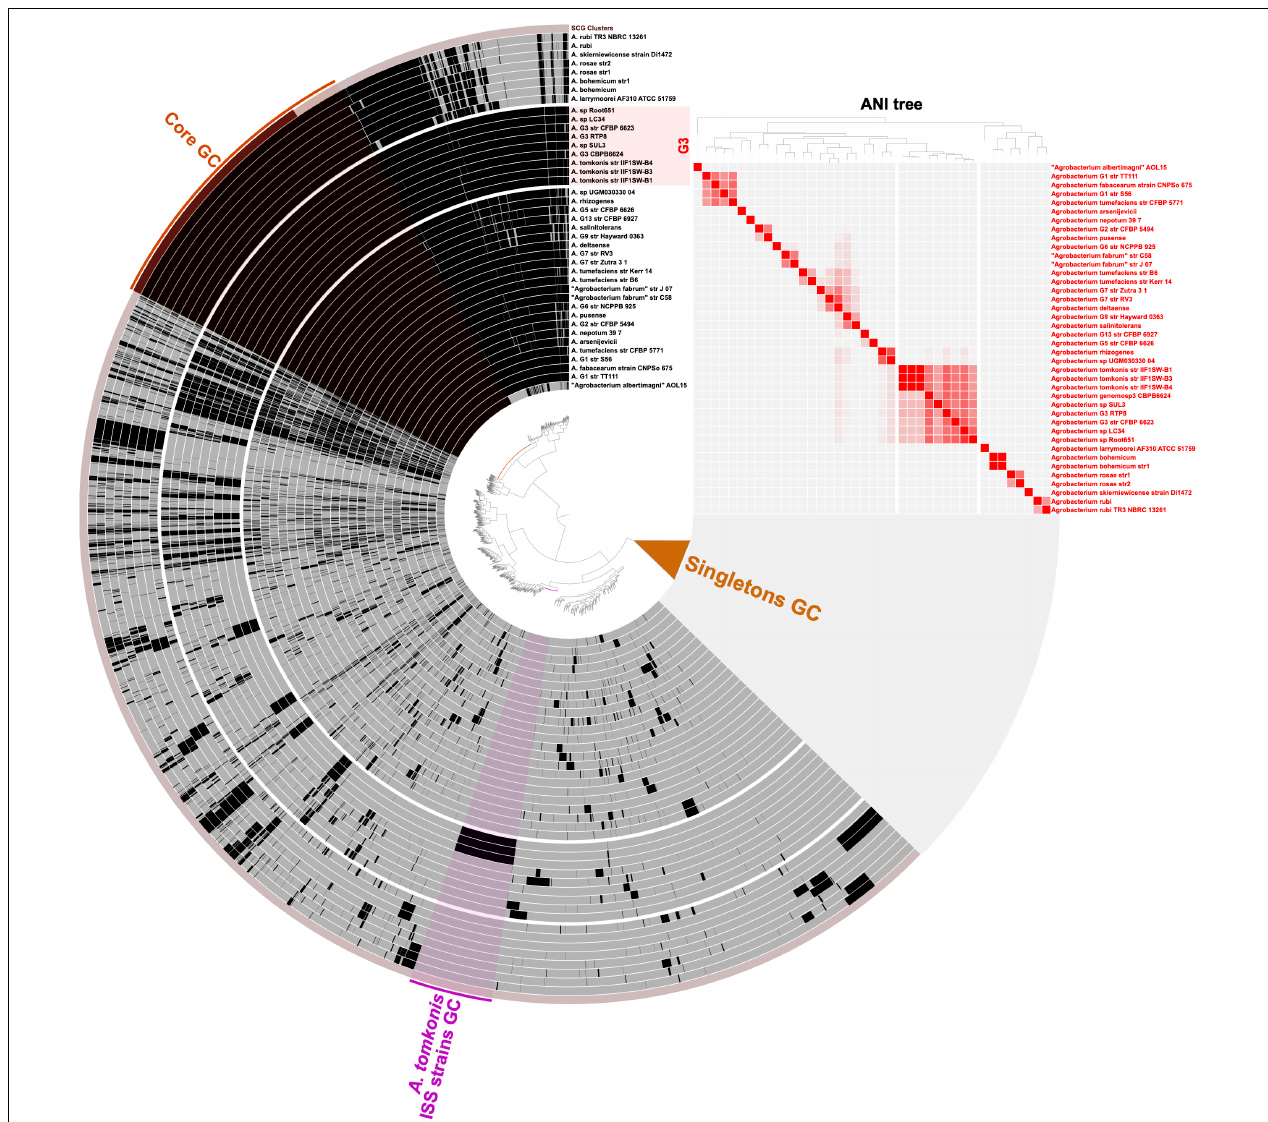
FIGURE 3 | Visualization of the Agrobacterium pangenome. Genomes are ordered as layers using a tree based on average nucleotide identity (ANI) values matrix (Euclidean distance, Ward clustering). Color hue of ANI values are ranging from 70% ANI (white) to 100% ANI (red) and displayed as a heatmap on the right-side panel. Gene clusters are represented as vertical black bars indicating their presence in each genome layer. The central tree is ordering gene clusters based on their presence/absence in genomes using Euclidean distance and Ward clustering. The “Core GC” highlight indicates the gene clusters identified in all genomes. Gene clusters that are found in a single genome are collapsed as “Singletons GC.” The “ A. tomkonis ISS strains GC” highlight indicates gene clusters found exclusively on the three strains isolated from the International Space Station. The figure was created in Anvi’o